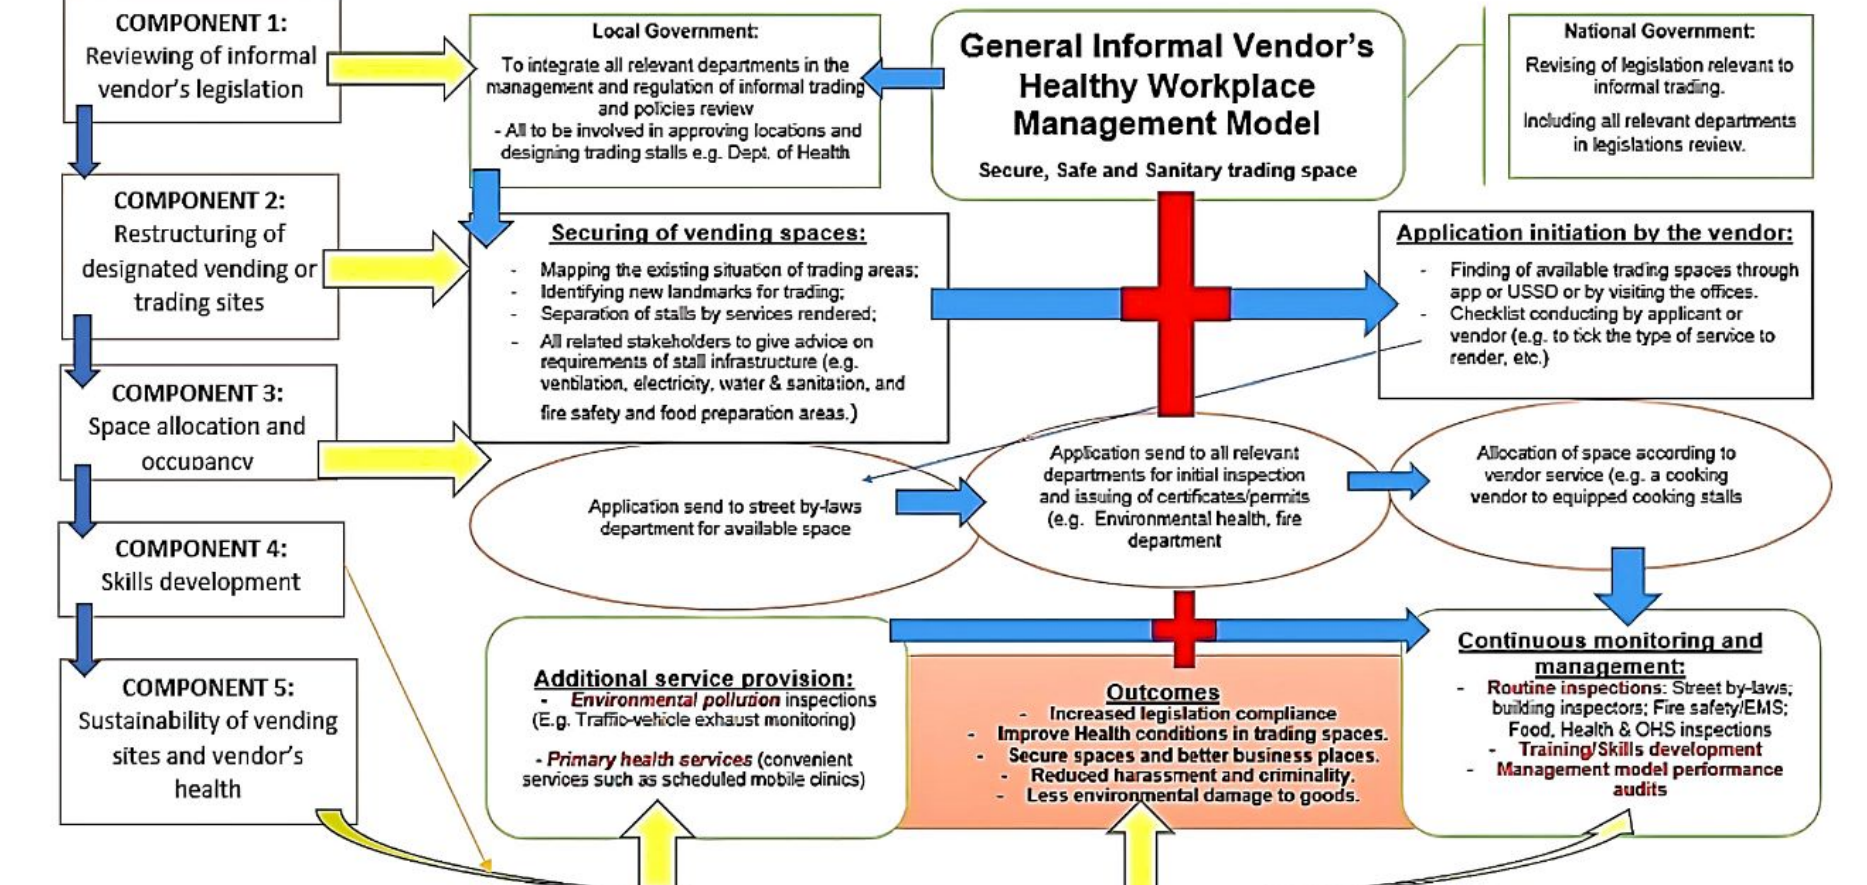
Figure 3. The general informal vendors’ integrated healthy workplace management model.